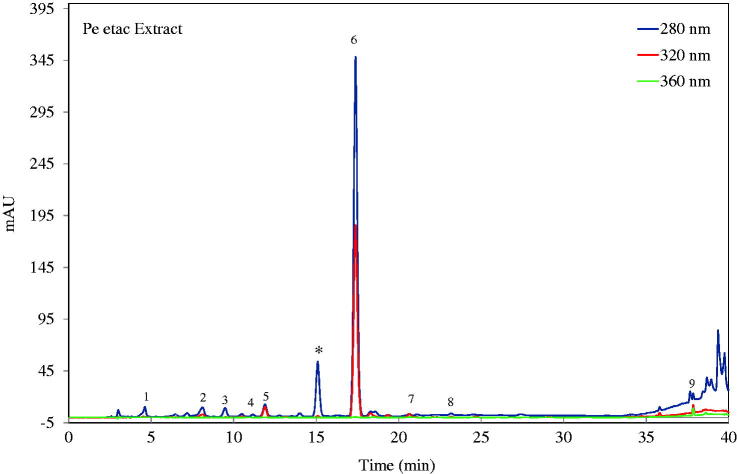
HPLC-PDA chromatogram of ethyl acetate extract of P. endlicherianum. (numbers are in Table 3; * is unidentified).